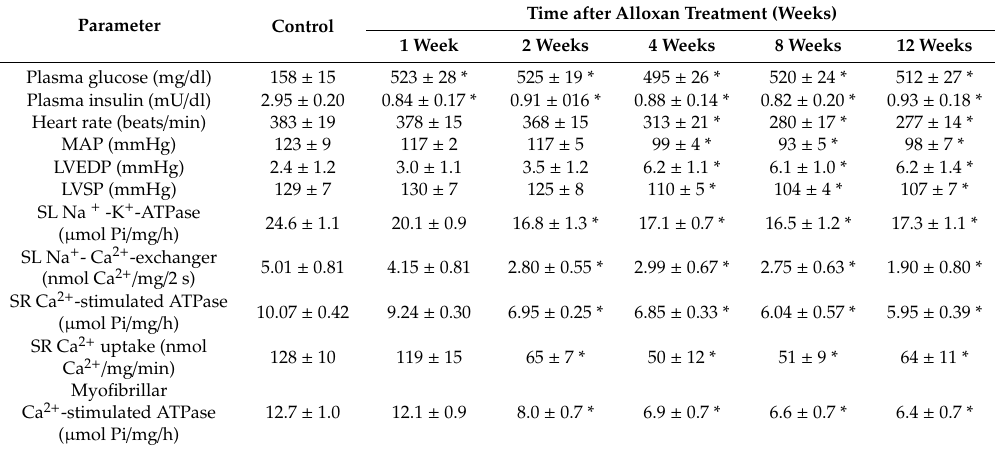
Table1. Timecourseofchangesinplasmaglucose / insulinlevels, cardiovascularfunctionandsubcellular activities in control and diabetic animals following alloxan injection. Time after Alloxan Treatment (Weeks) Parameter Control 1